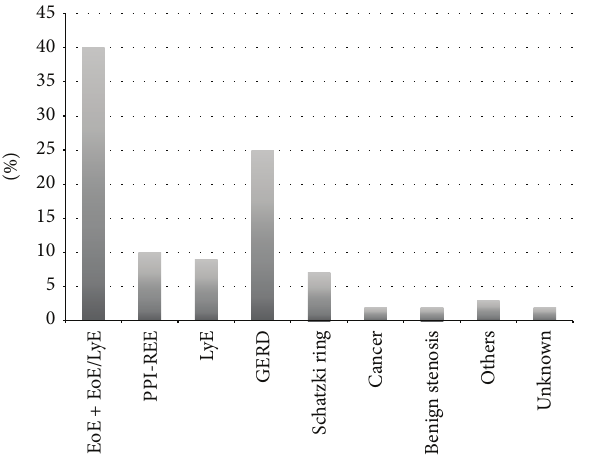
Figure 2: Aetiology of esophageal food impaction in 185 patients, in whom biopsies from the esophagus were obtained.